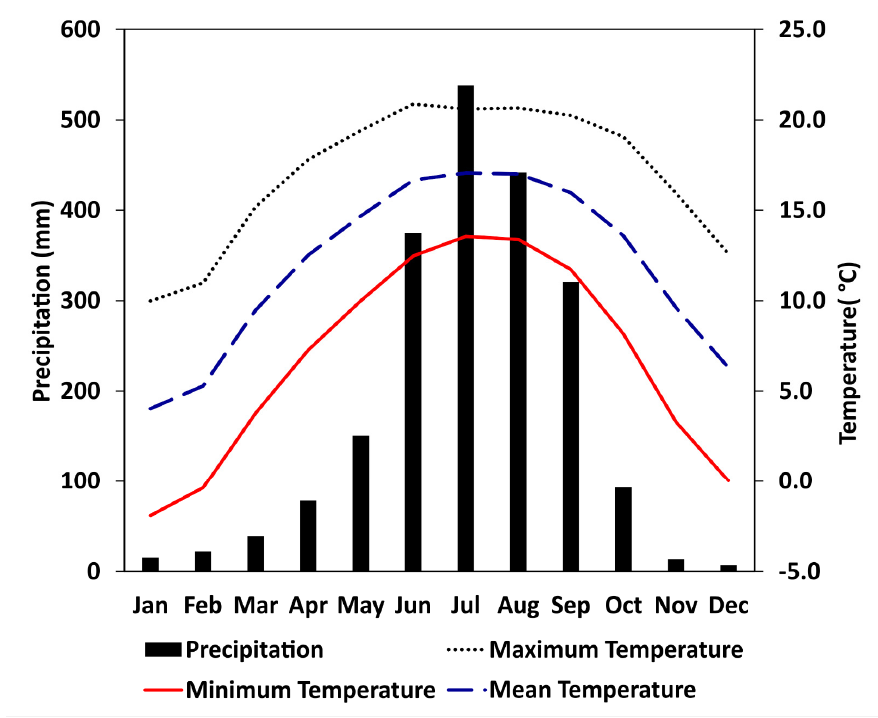
Figure 2. Climograph of North District, Sikkim represents average monthly data from 1901 to 2002;